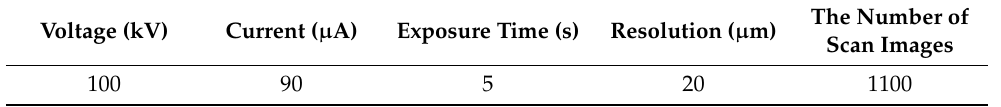
Figure 4. Zeiss Xradia 510 Versa high-resolution CT system ( a ) and interior ( b ). Table 2. Parameters for the Zeiss Xradia 510 Versa CT.